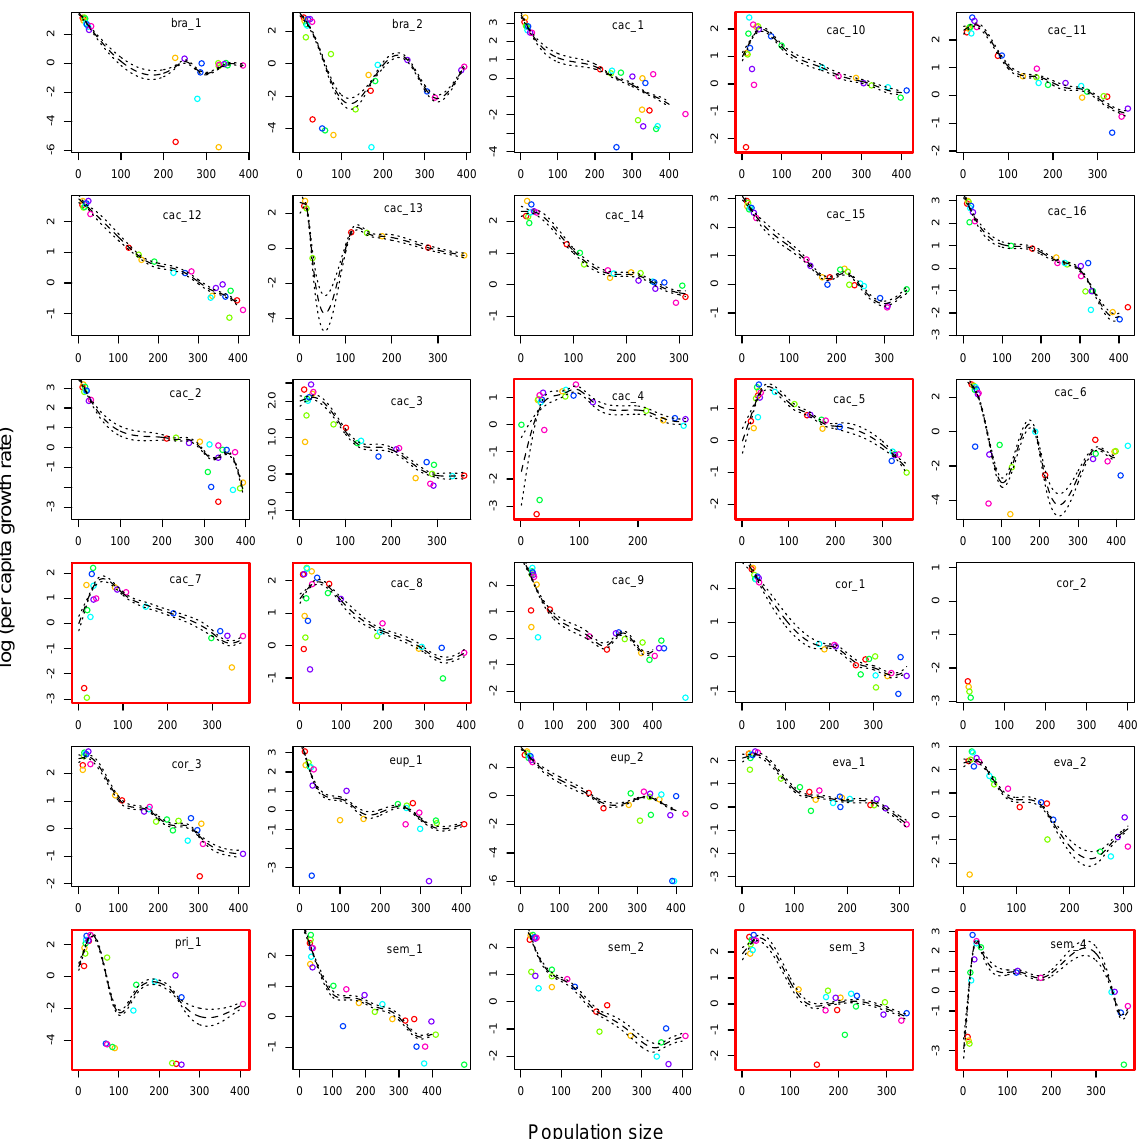
Figure 2. Raw data (circle of the same color belong to the same experimental replicate) and GAM fits (dashed lines: predicted values ; dotted lines: 95% confidence intervals around prediction) for the relationship between population size and per capita growth rate. Experimental data were modified as 𝑙𝑜𝑔 ( 𝑁 𝑡+1 +1 ) so that extinction events could be represented. Red boxes: populations characterized by an 𝑁 𝑡 Allee